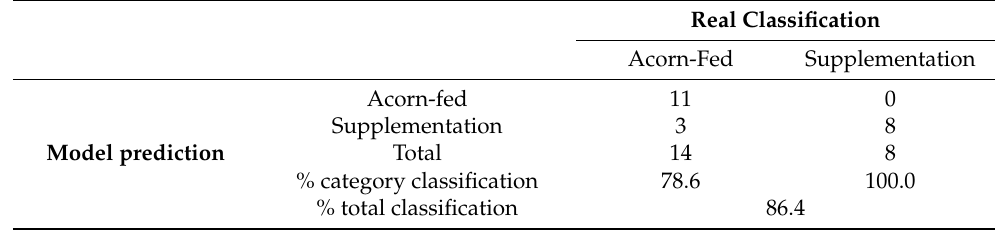
Table 1. External validation results (confusion matrix) obtained by the PLS-DA model (Model 1) using blind samples for the non-targeted approach (spectral fingerprint).